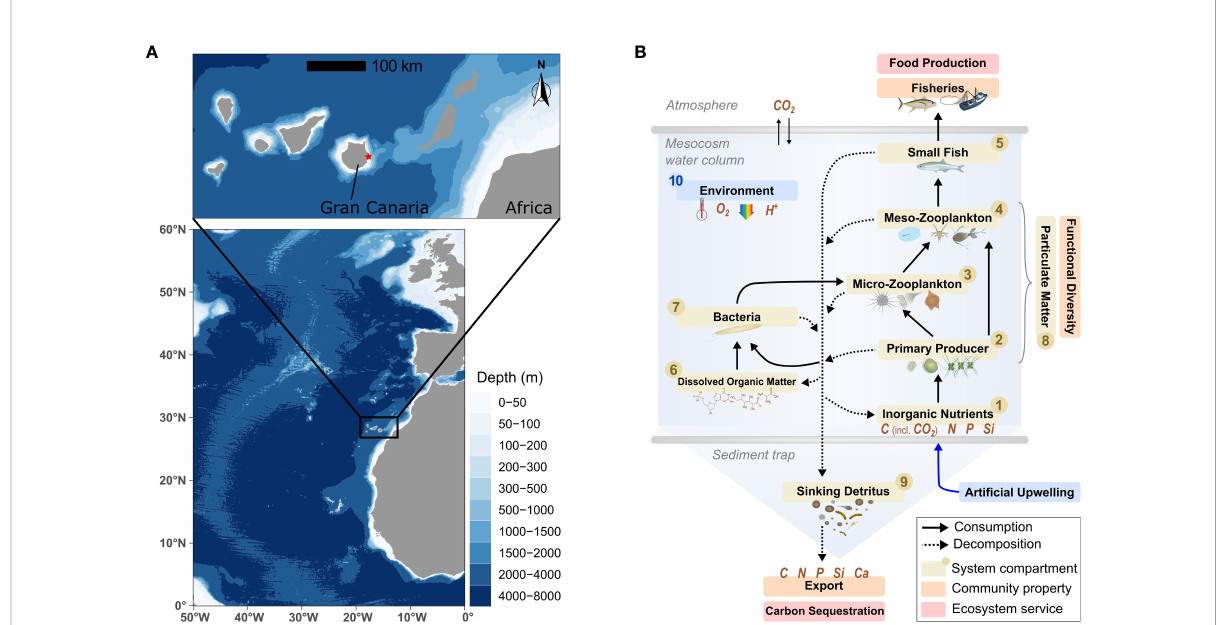
FIGURE 1 (A) Study site in the subtropical North Atlantic (red dot) (created with ggOceanMaps, Vihtakari, 2021). (B) Conceptualization of our pelagic mesocosms system. An overview of the parameters assessed for compartments #1-10 is provided by Table S1. Symbols from the Integration and Application Network